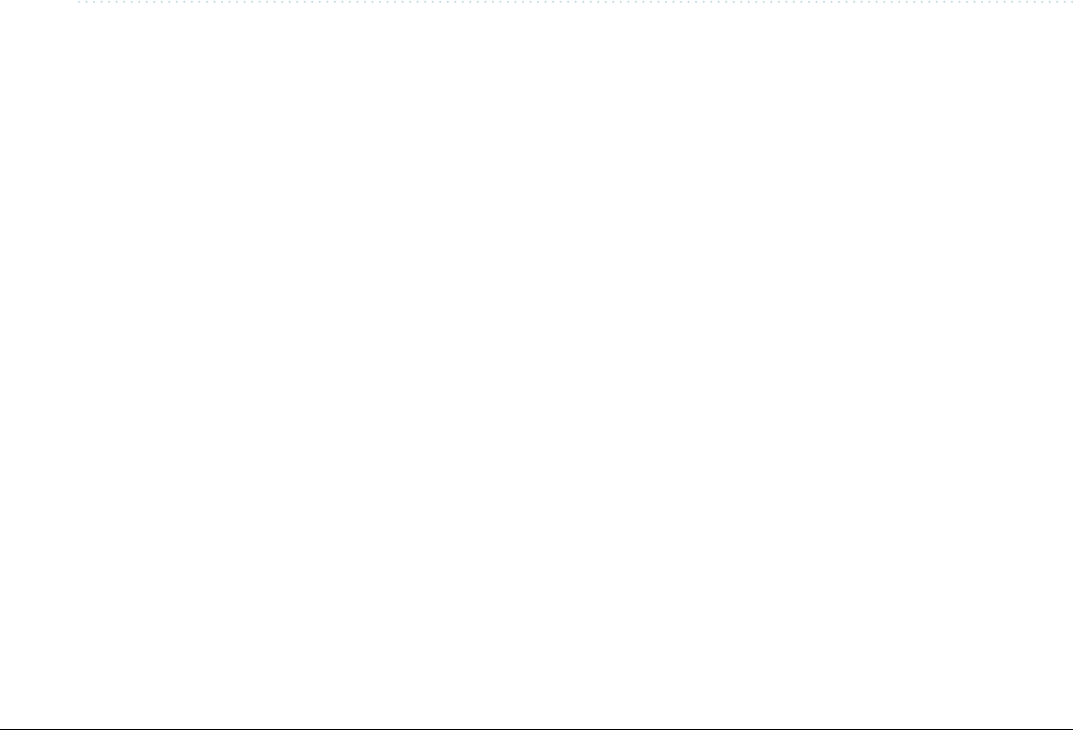
Figure 10. Cole–Cole plot ( a ), δ ( b ), and σ AC ( c ) for the prepared